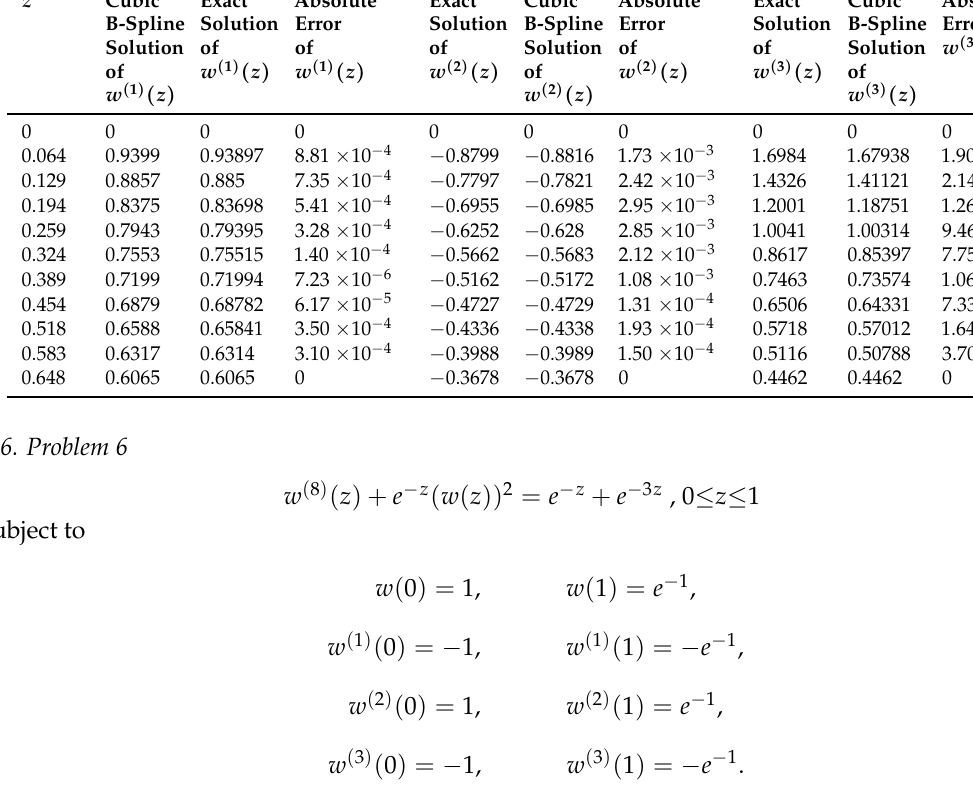
Table 17. Comparison of exact solution and presented method solution of Problem 6 at h = 1